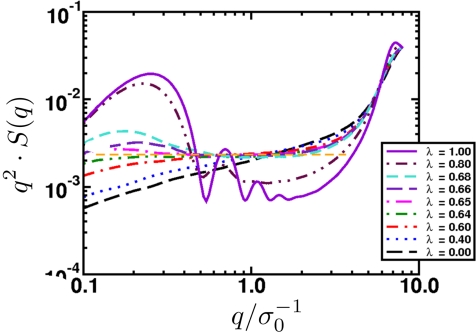
Kratky plot of S(q) of linear chains (N = 2000) for different values of the interaction parameter λ.